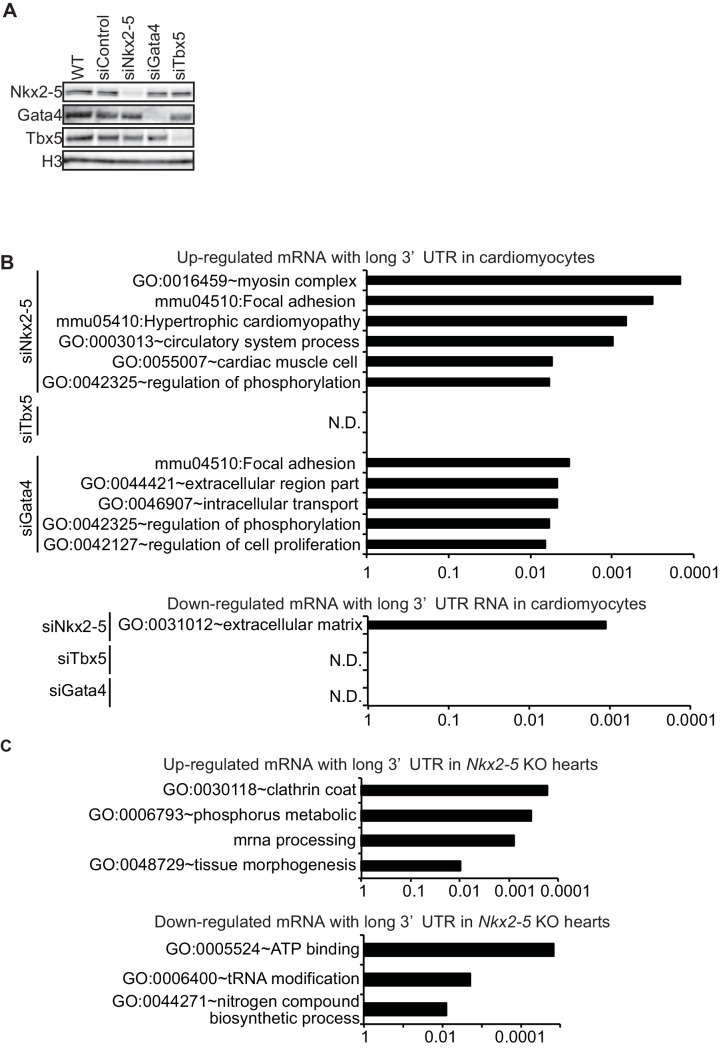
Functional annotations of genes with increased and decreased mRNA with long 3’UTR.(A) The knockdown of Nkx2-5, Gata4, and Tbx5 in eCMs was analysed by Western blotting. siNkx2-5, Nkx2-5 siRNA; siTbx5, Tbx5 siRNA; siGata4, Gata4 siRNA; WT, wild type. (B, C) Enriched gene ontologies in eCMs (for up-regulated genes: siNkx2-5,89 genes; siTbx5, 58 genes; siGata4, 182 genes. for down-regulated genes: siNkx2-5, 12 genes; siTbx5, 9 genes; siGata4, 13 genes) and E9.5 Nkx2-5-/- hearts (up-regulated genes, 200 genes; down-regulated genes, 90 genes) are shown. N.D., not detected. The p value is plotted on the x-axis.